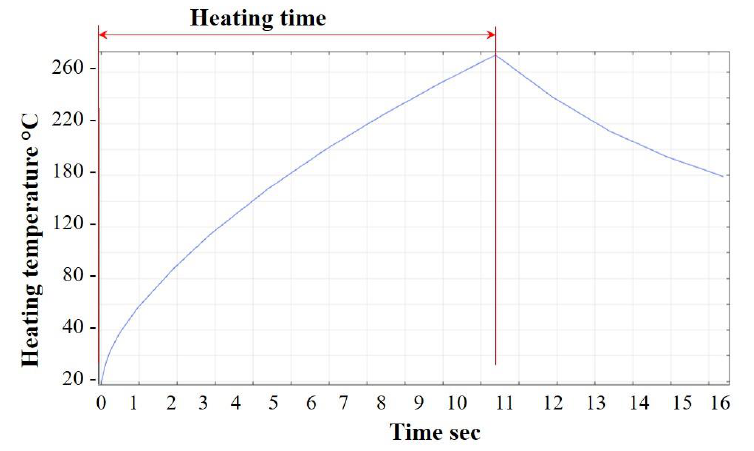
Figure 7. Simulated heating temperature of the II+Al sample.